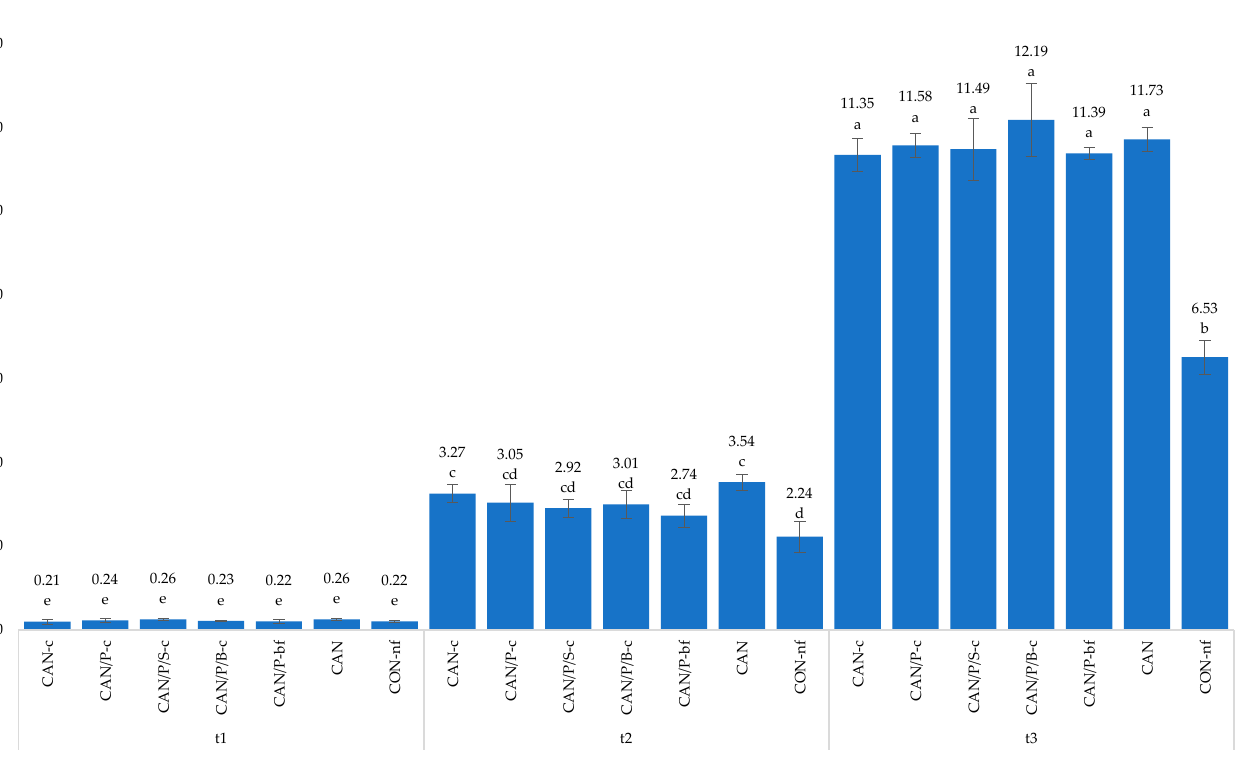
Figure 5. Dry matter weight of maize AGB (g/1 plant). The weights of AGB are expressed as mean (n = 4); the error bars represent the standard deviation. Different letters above error bars denote statistically significant differences among treatments using Tukey’s post hoc tests. CAN-c: 100% CAN with P3HB coating; CAN/P-c: 50% CAN + 50% P3HB with P3HB coating; CAN/P/S-c: 50% CAN + 25% P3HB + 25% struvite with P3HB coating; CAN/P/B-c: 50% CAN + 50% biomass with P3HB coating; CAN/P-bf: 50% CAN + 50% P3HB encapsulated in biodegradable film; CAN: 100% CAN (positive reference); CON-nf: without fertilizer (negative reference).